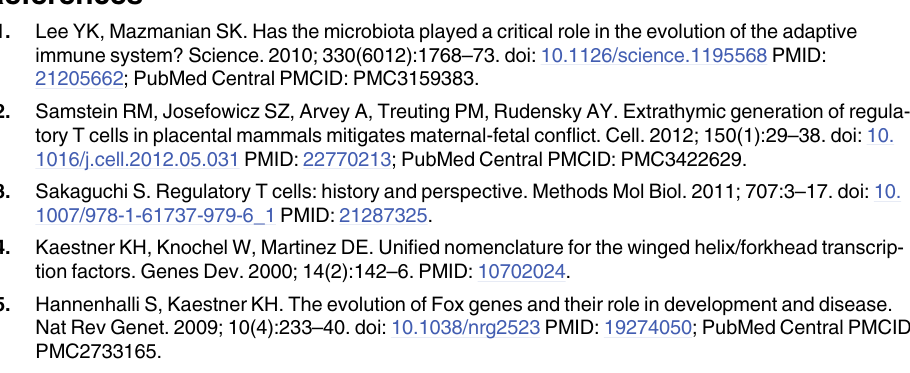
S1 Table. Mammalian, reptilian and amphibian NCBI genome information. S2 Table. Avian NCBI genome information. S3 Table. FoxP3 proline enrichment in birds, bony fish and